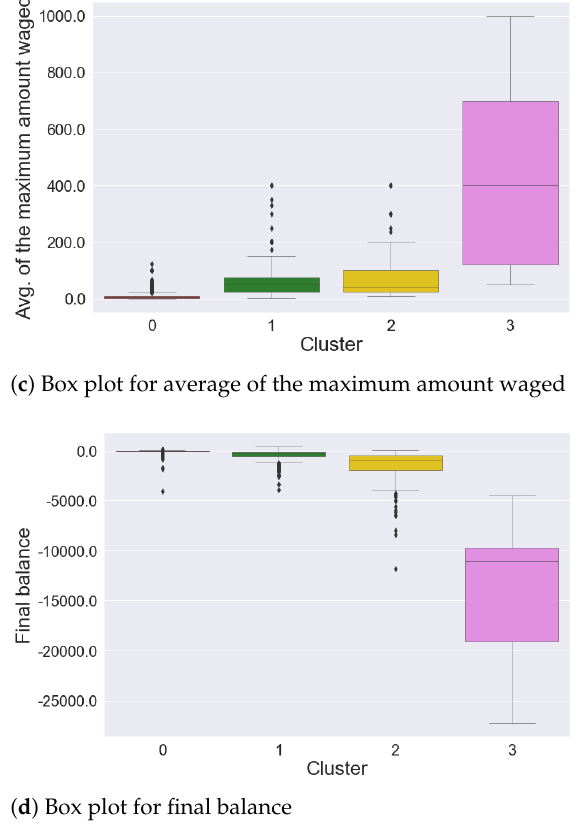
Figure 14. Box plots for black jack bets’ data using the time series k -means